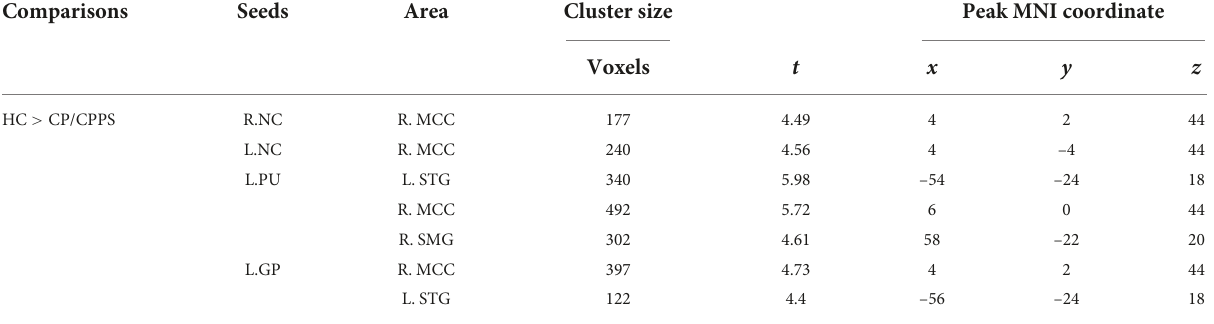
TABLE 3 The seed-based functional connectivity analysis.